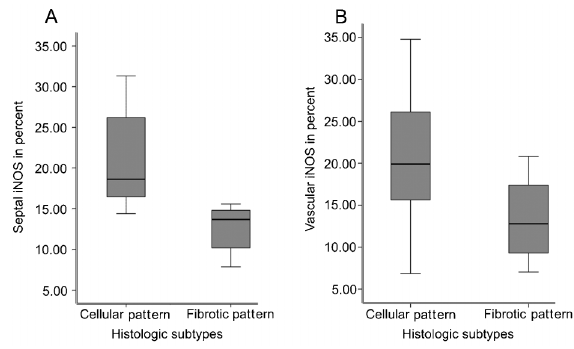
Figure 4. Box plot shows septal ( A ) and vascular ( B ) iNOS expression between cellular and fibrotic histological